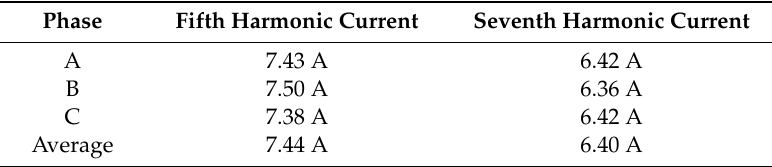
Figure 4. Waveforms of fundamental current control with a distorted grid voltage: ( a ) output current, and ( b ) FFT (fast frequency transform) analysis results. Table 2. FFT analysis results under the distorted grid condition.